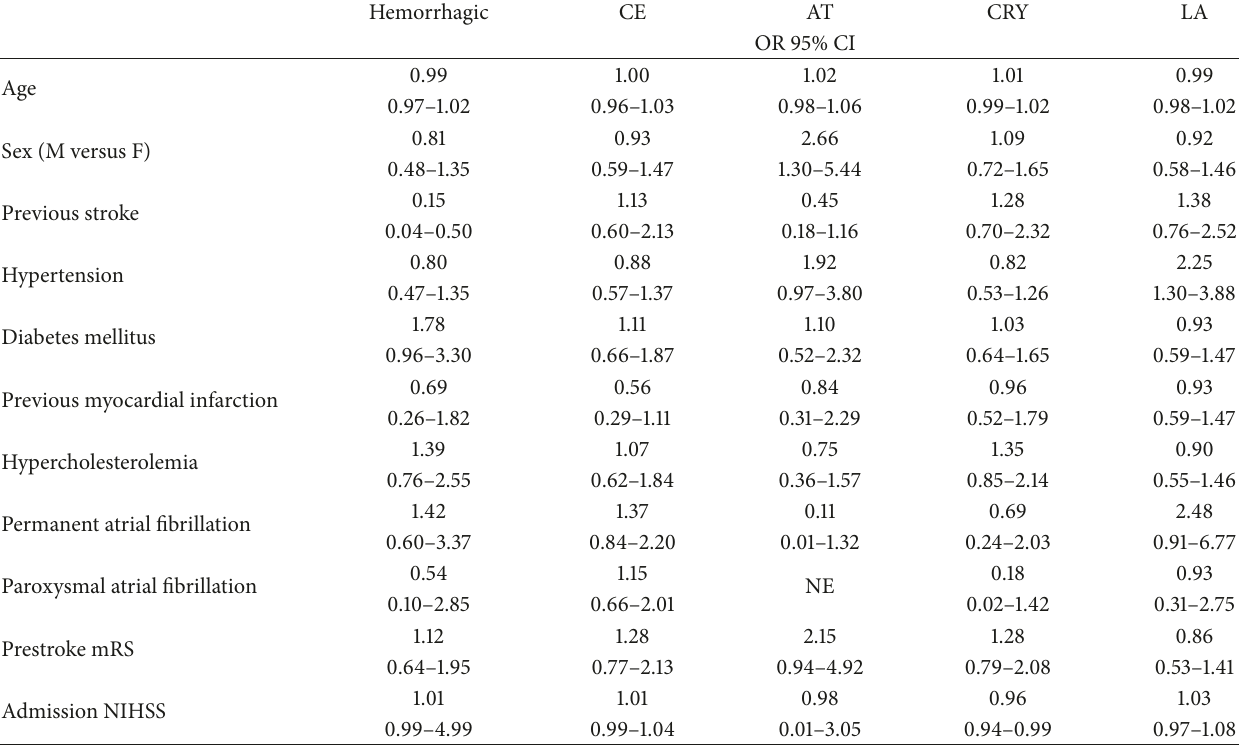
Table 4: Multivariate logistic regression among demographic variables and risk factors (both independent variables) with daytime onset in different stroke subtypes. 8–11 versus all other periods (dependent